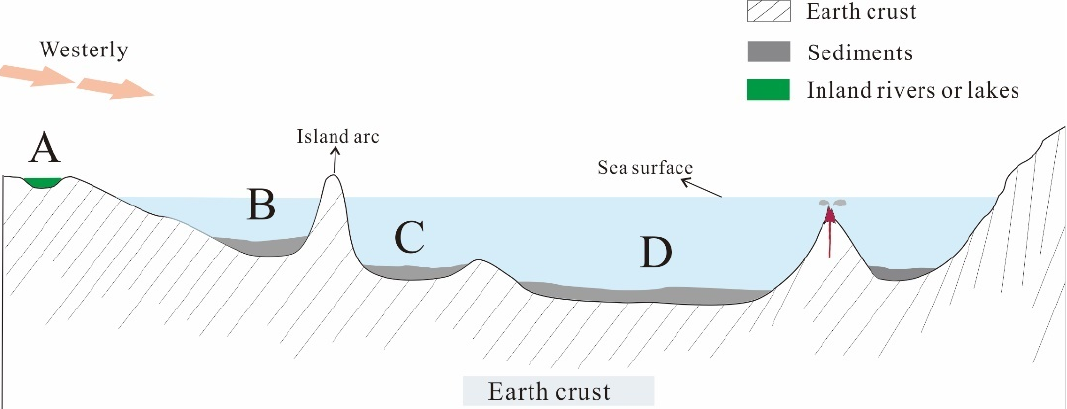
Figure 11. Sedimentary profile from continent to the ocean. A represents inland sedimentation (inland rivers or lakes), B represents marginal sea sedimentation, C represents back-arc basin sedimentation, D represents pelagic sedimentation.